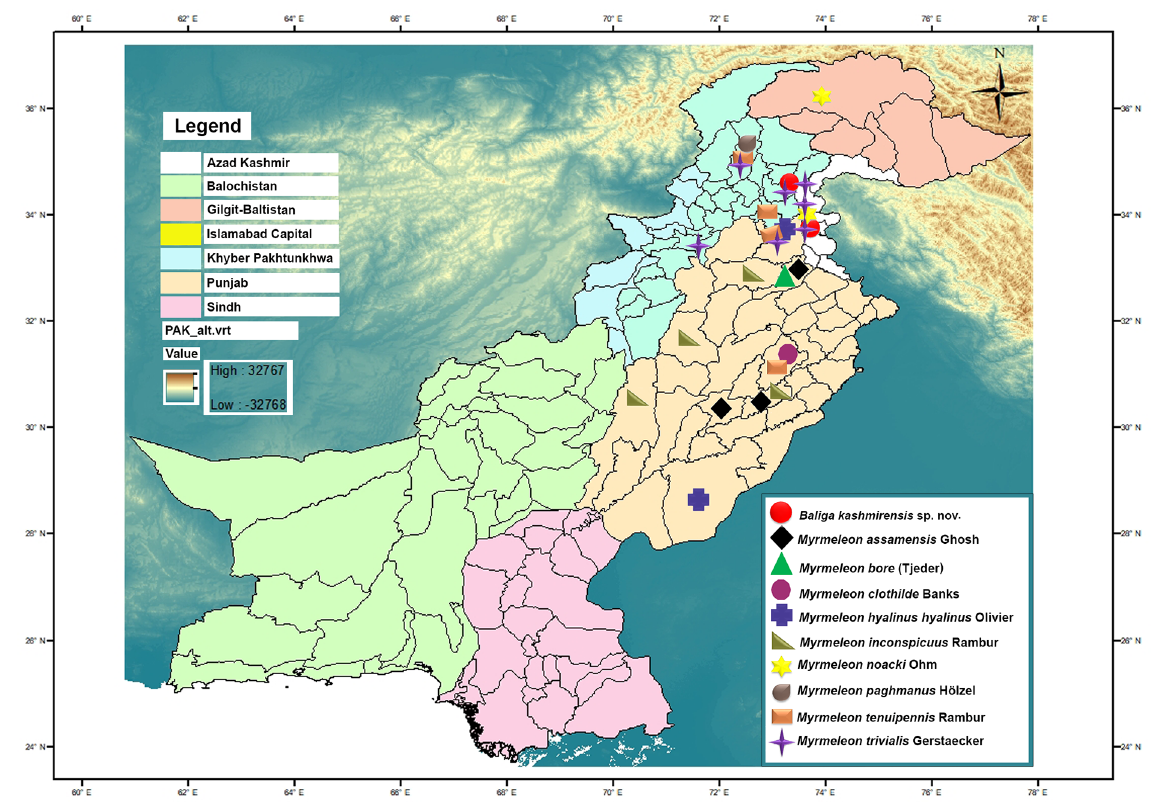
Fig. 20. Distribution map of species of Baliga Navás, 1912 and Myrmeleon Linnaeus, 1767 from